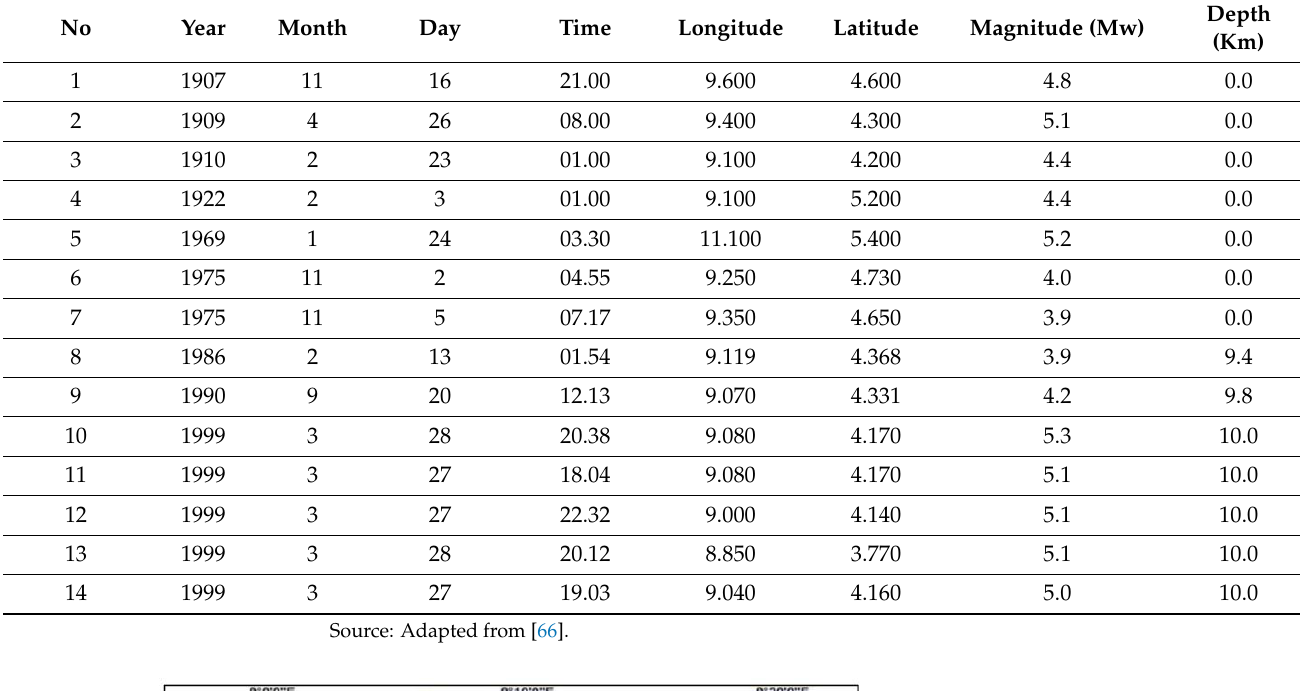
Table 1. Main recorded earthquakes along the CVL.